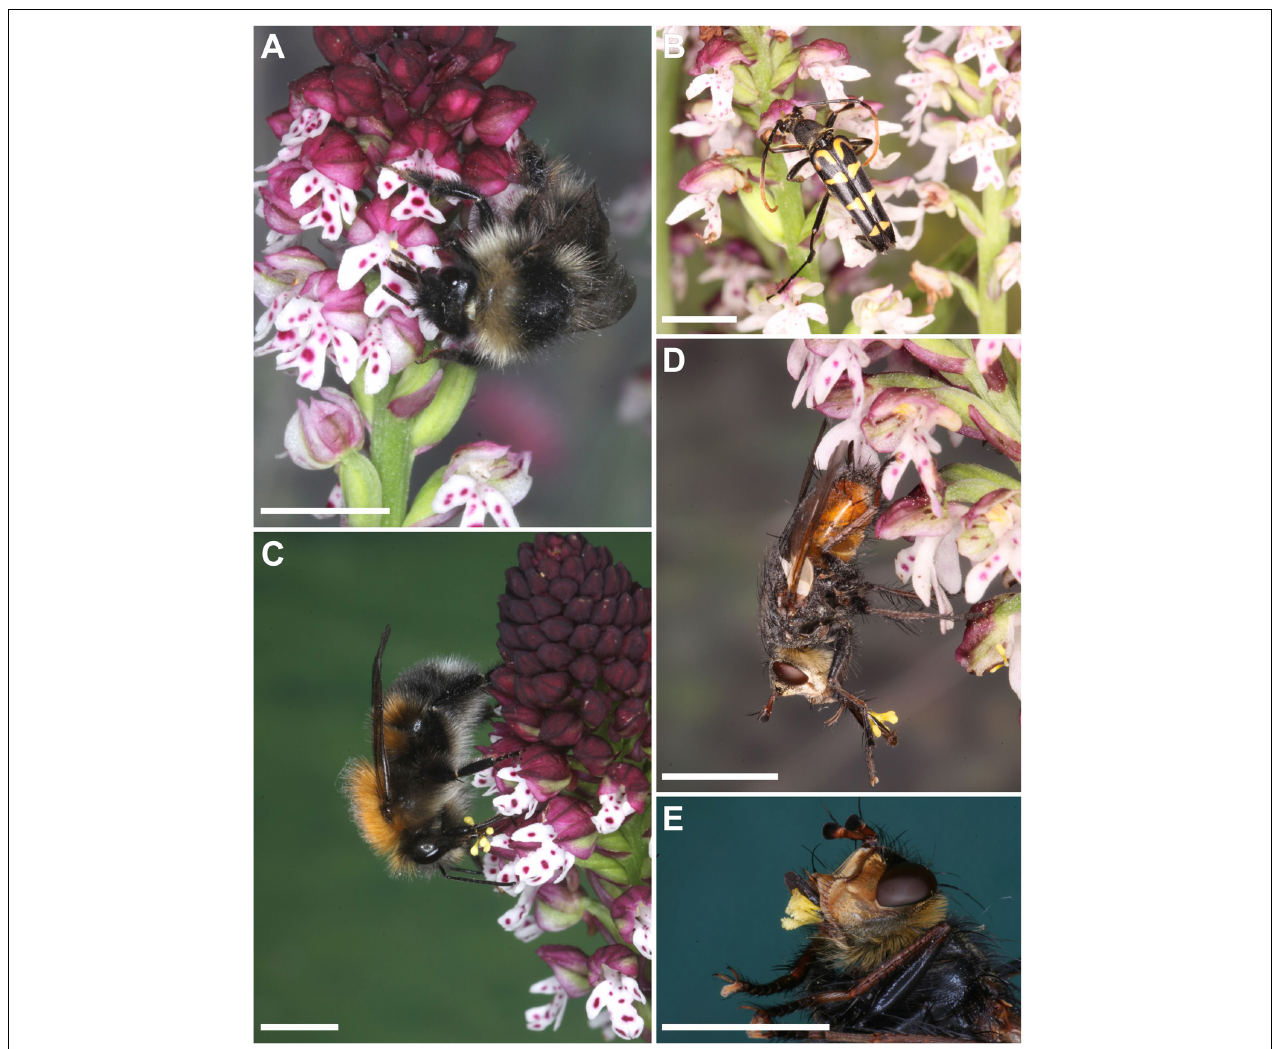
FIGURE 8 | Pollinators of Neotinea ustulata : (A) Bombus mucidus , (B) Leptura annularis , (C) Bombus hypnorum , (D) Tachina fera , (E) Tachina fera close-up. They were recorded visiting flowers of N . ustulata var. ustulata (A,B,D,E) and var. aestivalis (C) . White bars represent scale of 5 mm. Photographs by H. Paulus.